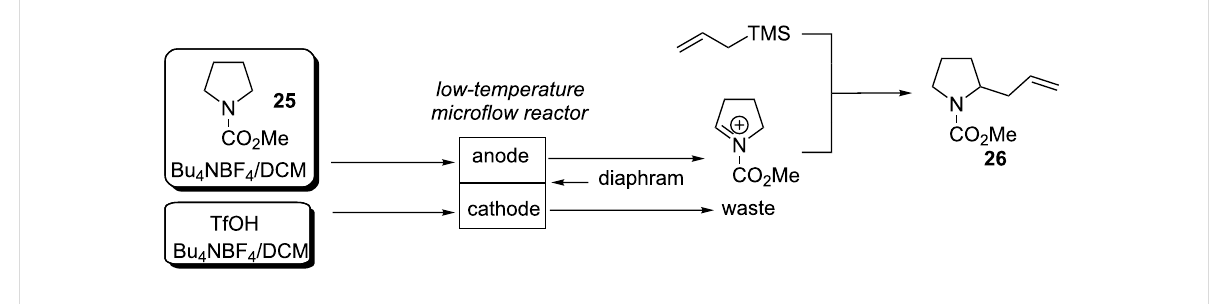
Figure 1: Schematic of a cation flow system and also shown is the electrochemical microflow reactor reported by Suga et al. Figure redrawn from reference [30].